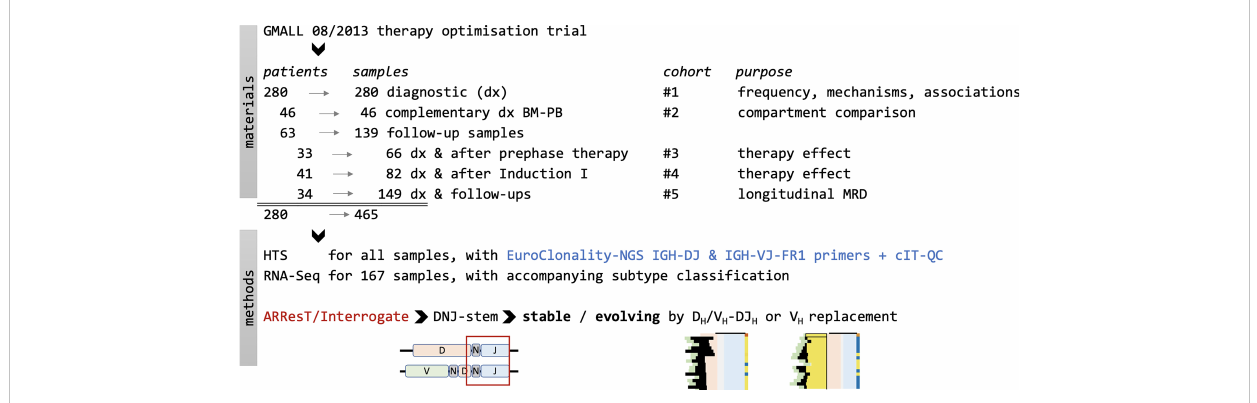
FIGURE 1 Study overview. A total of 465 samples from 280 patients with BCP-ALL enrolled in the GMALL 08/2013 therapy optimization trial were analyzed in fi ve different cohorts to decipher frequency, mechanisms and kinetics of the leukemic clonal evolution. The bioinformatic analyses on IGH HTS data were carried out on DNJ-stem sequences identi fi ed by ARResT/Interrogate (25). Transcriptome sequencing and molecular subtype calling were performed as described by Bastian et al. (26) HTS, high-throughput sequencing; RNA-Seq, RNA next- generation